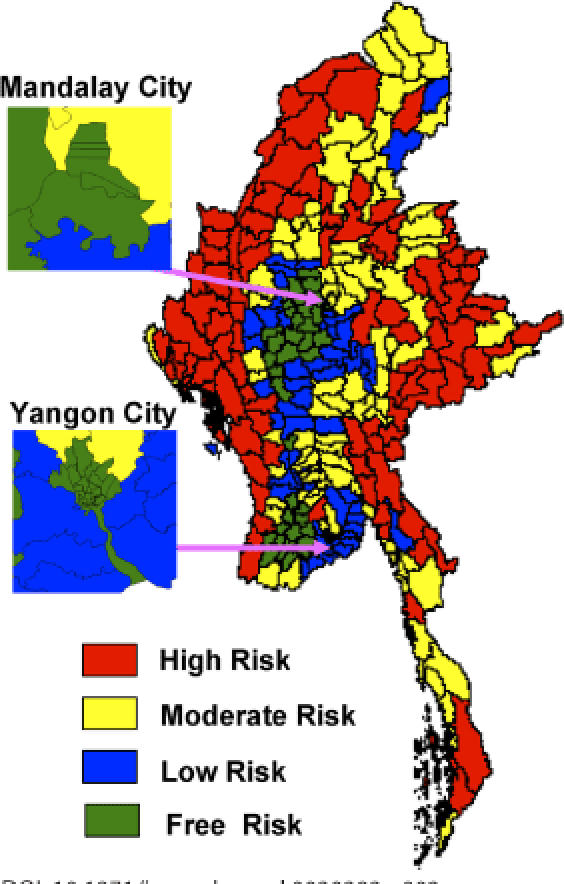
Malaria Risk Areas in BurmaThe areas at highest risk are overwhelmingly along the frontiers, where civil confl ict is ongoing and widespread human rights abuses have been documented.Source: WHO Regional Offi ce for South-East Asia [76]